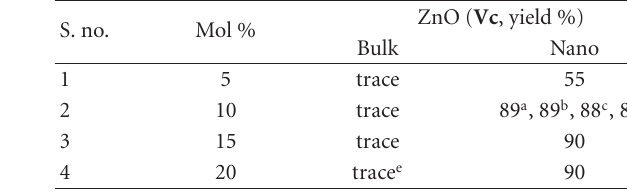
Table 1: Optimization of the catalyst.